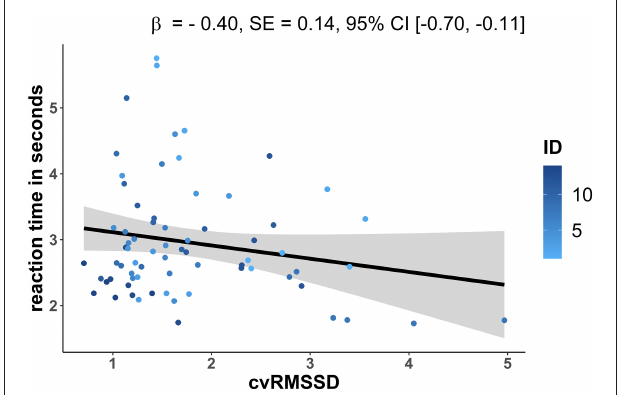
FIGURE 2 | LME results for the model with reaction time (s) as dependent variable (y-axis) and the fixed factor cvRMSSD (coefficient of variation: RMSSD/meanRR *100) on the x-axis. The trajectories are shown for each subject (colored dots, N = 14) and for the estimated group model (black dashed line) with a 95% confidence interval (gray area). The LME analysis revealed a significant influence of cvRMSSD on the reaction time. β , beta coefficient of measurement time point effect; SE , standard error; 95%- CI , 95% confidence